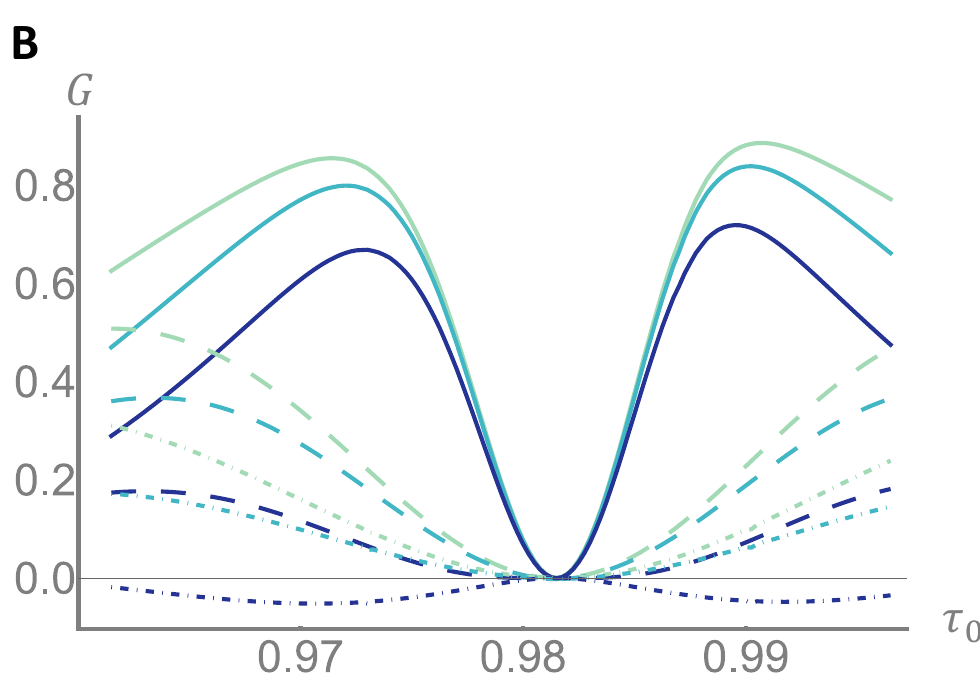
Figure 4. Inefficiency effect. We report the quantum gain over the three classical limit defined in the main text, for different values of overall efficiency η . In panel ( A ), we show the dependency of the gain on the main number of signal photons µ . The case of perfect efficiency η = 1 is reported in solid line, while the cases η = 0.9 an η = 0.8 are reported in dashed and dot dashed lines respectively. The distributions g 0 and g 1 are the same reported in the first row of Figure 2, namely ¯ τ 0 = 0.972, ¯ τ 1 = 0.982 and σ 0 = σ 1 = 0.001. In panel ( B ), we fix the number of photons to µ = 10 4 and we show the dependency on the mean transmittance ¯ τ 0 .